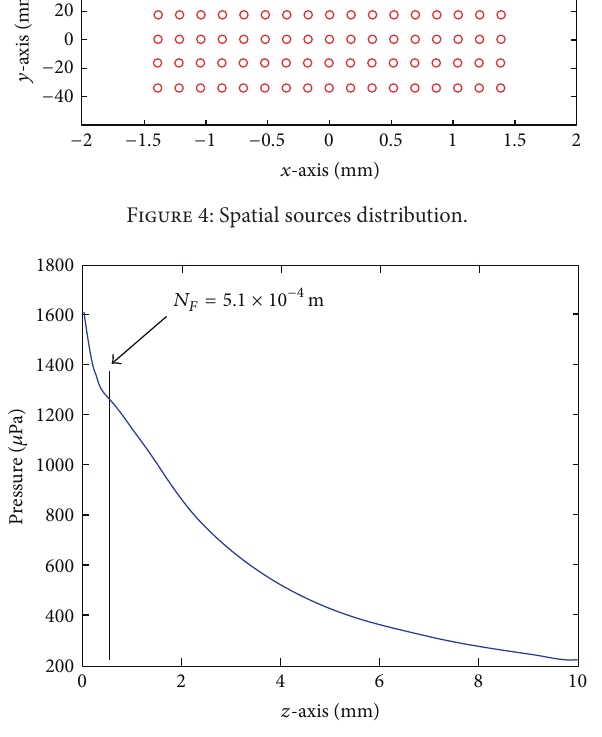
Figure 5: Acoustic pressure along 𝑧